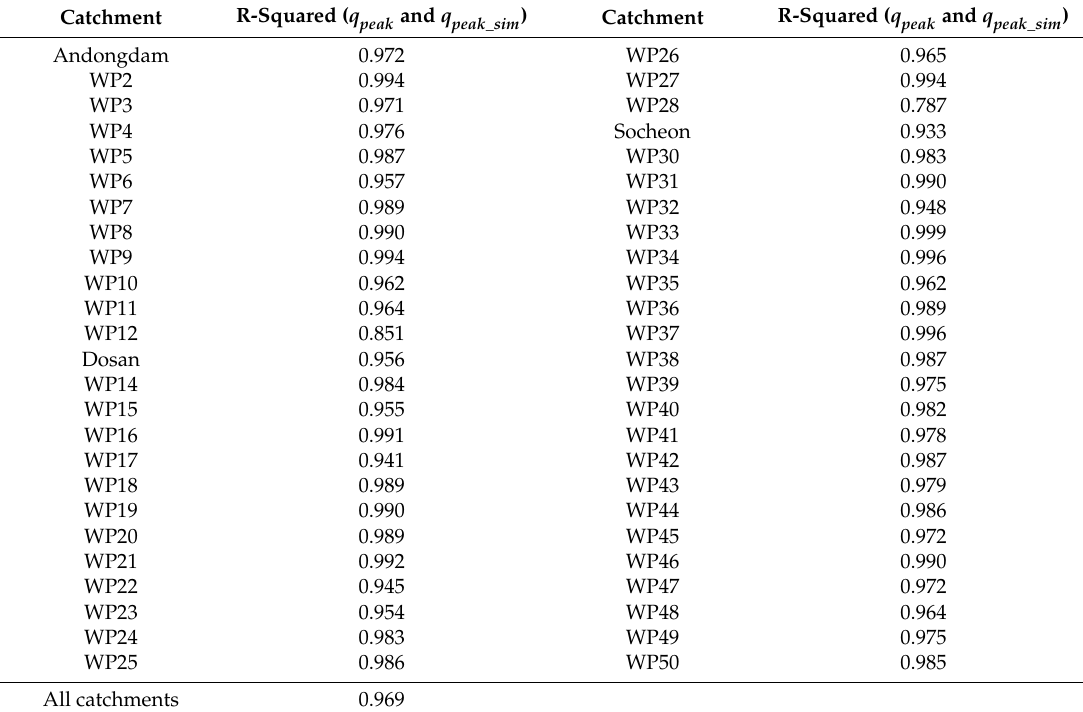
All catchments 0.969 Table 3. NSE values for the peak flow ( q peak ) and simulated peak flow ( q peak _ sim ). Catchment NSE Catchment NSE Catchment NSE